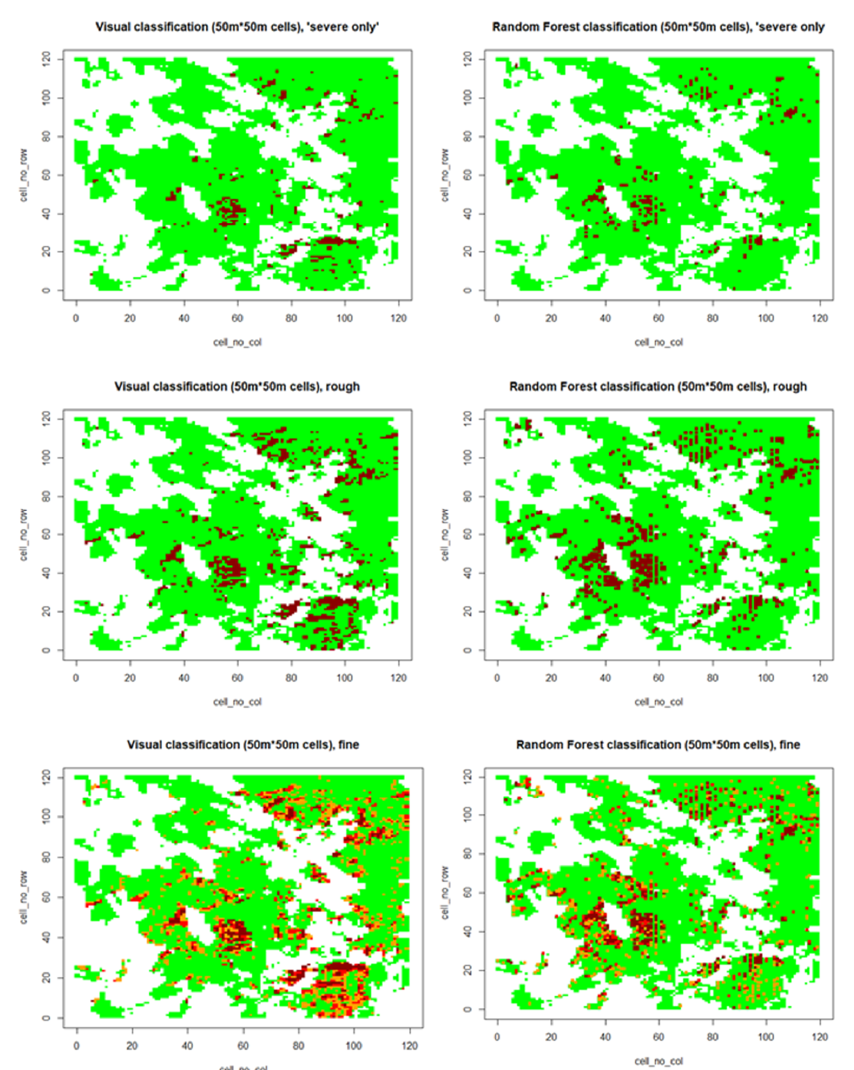
Figure 4. Comparison of classification results. In the left column results of the visual classification are shown. In the right column the results of the random forest classification are presented. The results of the differentiation (according to Table 4) are represented by lines. Each pixel represents a raster cell with a size of 50 × 50 m. Green cells represent forest areas that were not affected by storm damage, while red cells represent windthrow cells (in case of fine distinction: orange = E, red = M, dark-red = S). White cells indicate no forest